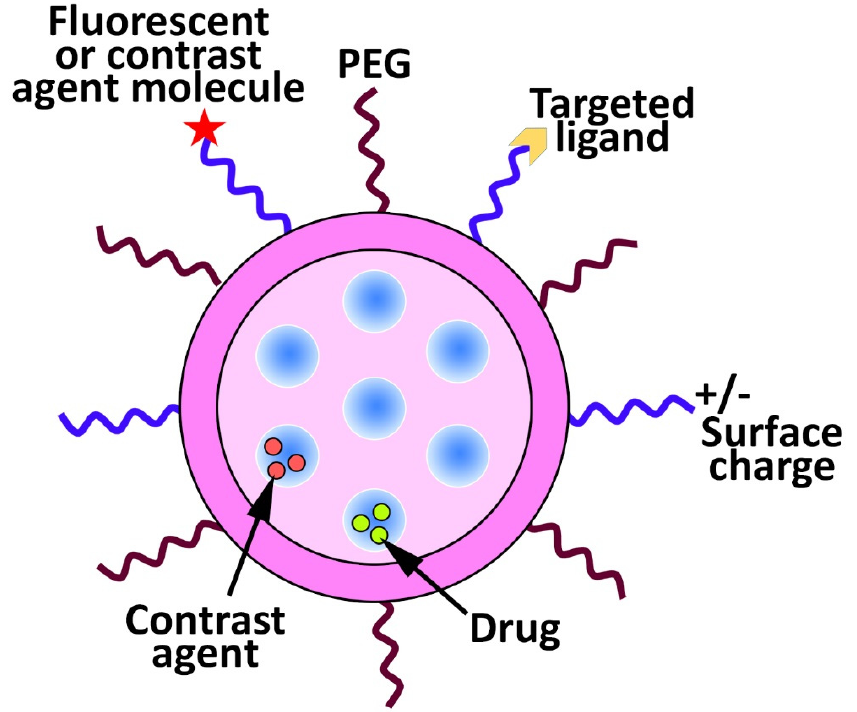
Figure 1. Surface multi-functionalization of mesoporous silica nanoparticles (MSNs) to produce a targeting and stimuli-responsive delivery nanosystem. For this purpose, various types of functional- ities, such as polyethyleneglycol (PEG), fluorescent or contrast agents, and targeting ligands (e.g., protein, peptide, and antibody) can be attached to the surface of the nanoparticles. Additionally, the surface charge of the nanoparticles can be modulated, and the nanoparticles can be loaded with various types of drugs and/or contrast agents.